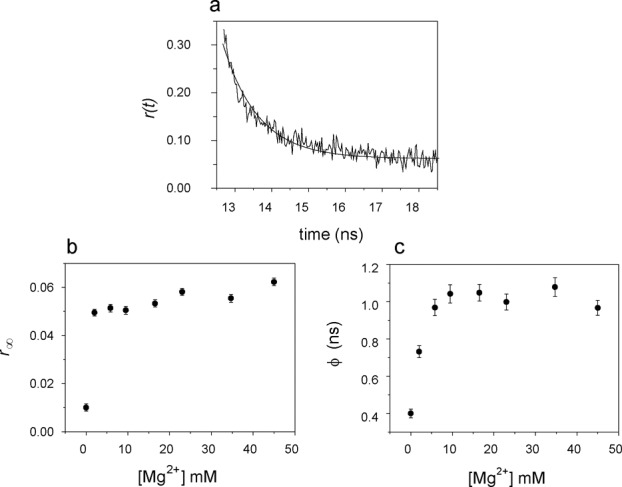
Time dependent anisotropy of Bim: dependence on the concentration of Mg2+. (a) Anisotropy decay of Bim in the L(dAp)ER(Bim) trimolecular complex at 45 mM MgCl2, decay curve analyzed with Equation (5); (b) residual anisotropy \documentclass[12pt]{minimal}
\usepackage{amsmath}
\usepackage{wasysym}
\usepackage{amsfonts}
\usepackage{amssymb}
\usepackage{amsbsy}
\usepackage{upgreek}
\usepackage{mathrsfs}
\setlength{\oddsidemargin}{-69pt}
\begin{document}
}{}$r_\infty$\end{document}; (c) rotational correlation time ϕ. Conditions: 4.2 μM L(dAp), 4.1 μM E, 4.0 μM R(Bim), pH 7.5; 15°C; λexc = 405 nm, λem = 480 nm.